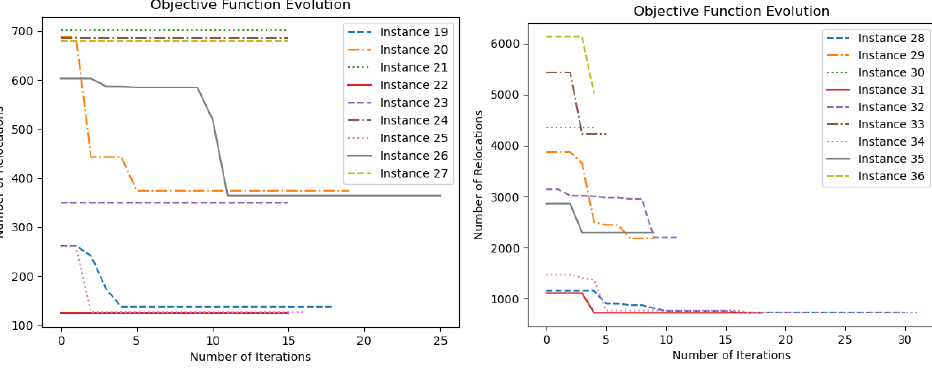
Figure 12. Evolution of the objective function of large-sized